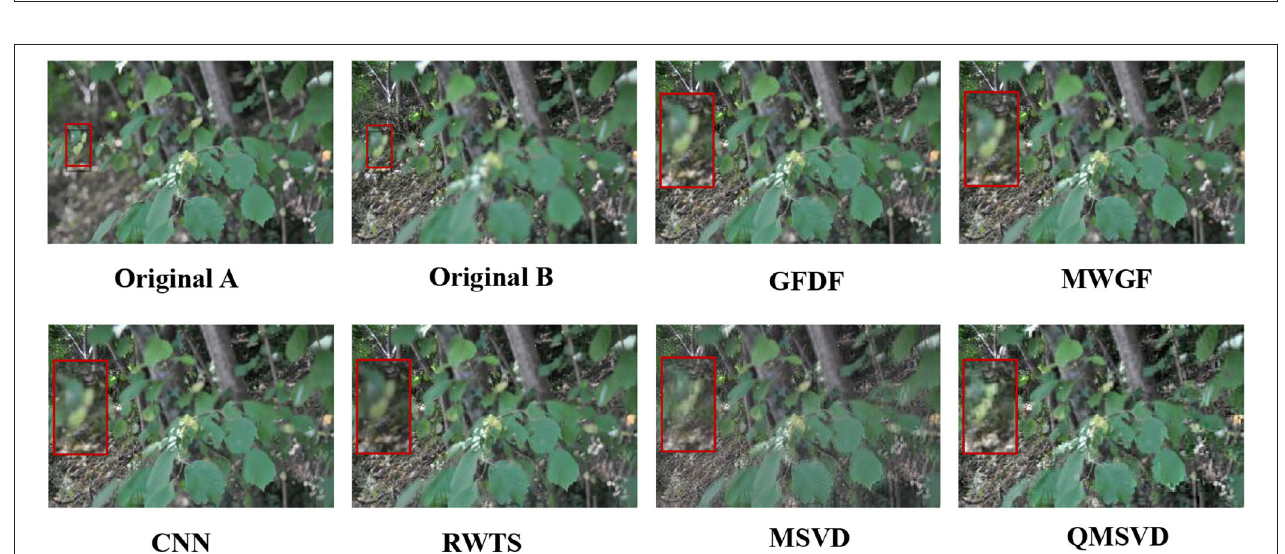
FIGURE 8 | “Coke Bottle” fusion images obtained by six different fusion methods.